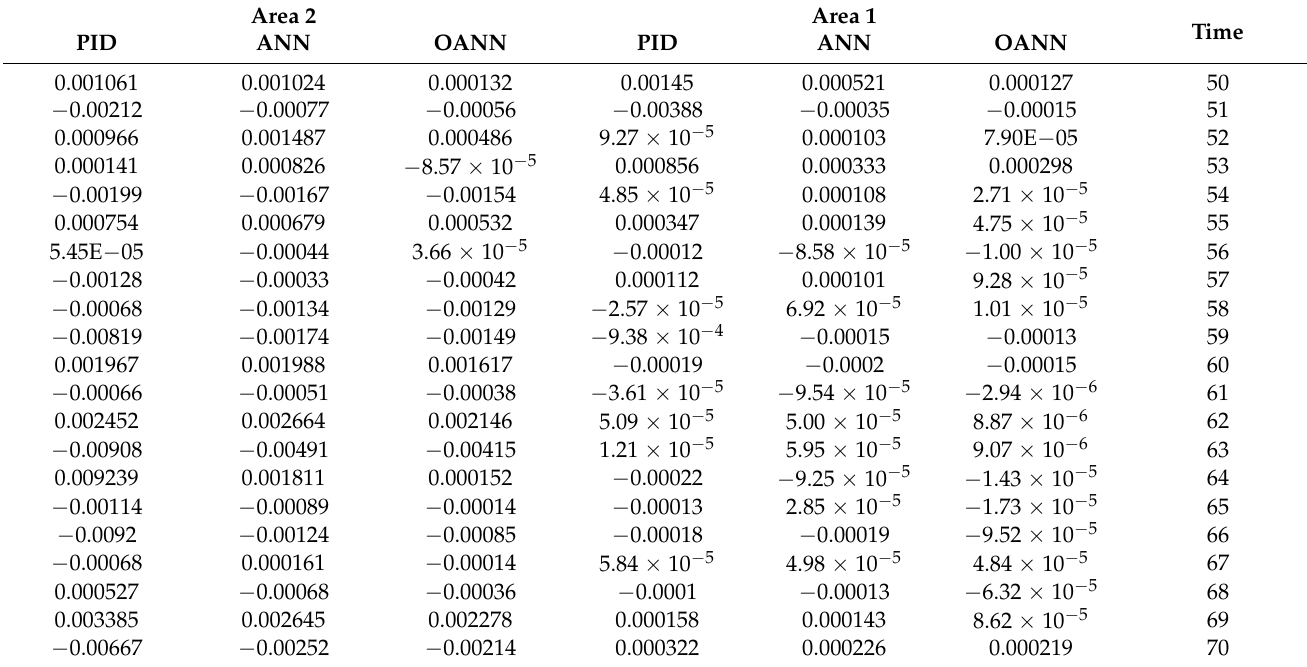
Table 7. Frequency deviation of LFC for a two-area PSN based on numerical results.